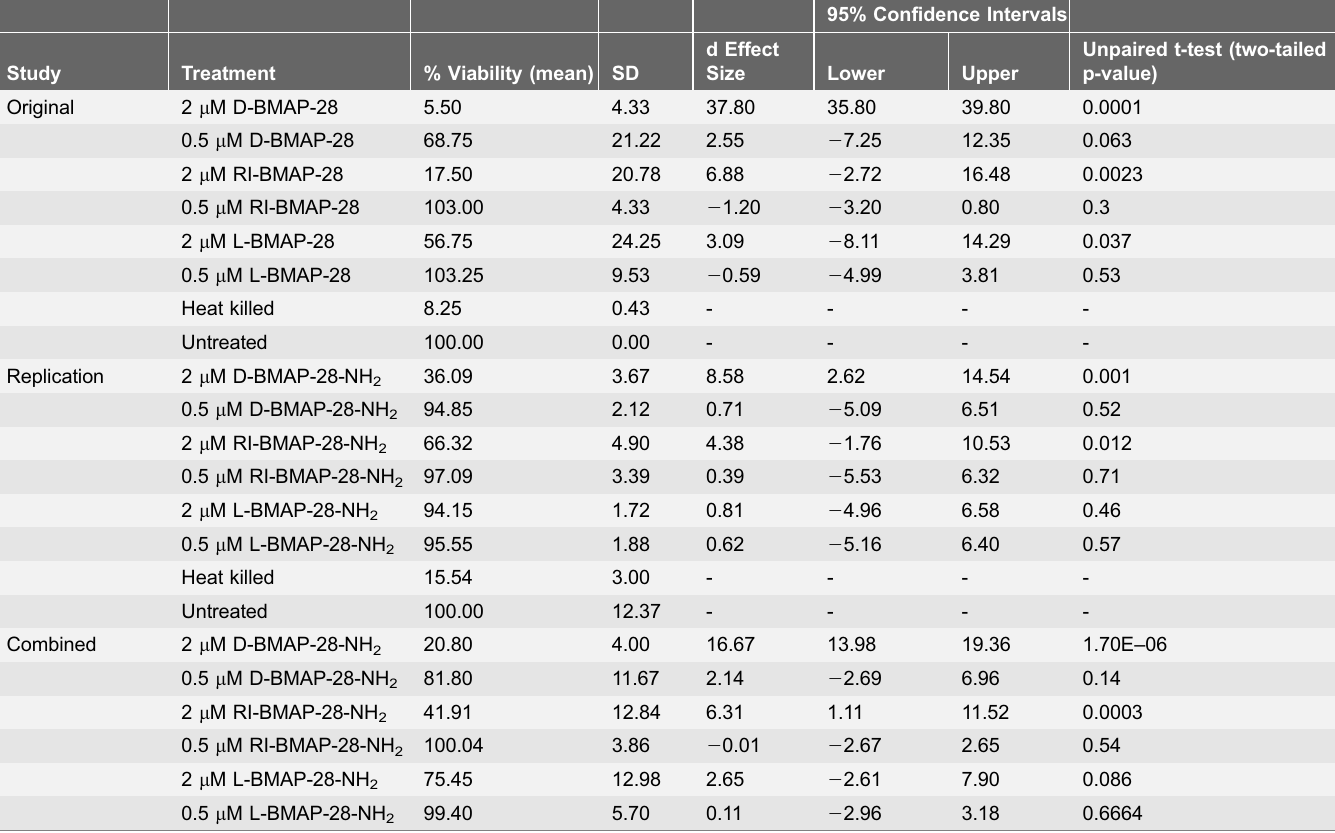
Table 1. Promastigote viability assay of Leishmania major when treated with 0.5 m M or 2 m M BMAP-28